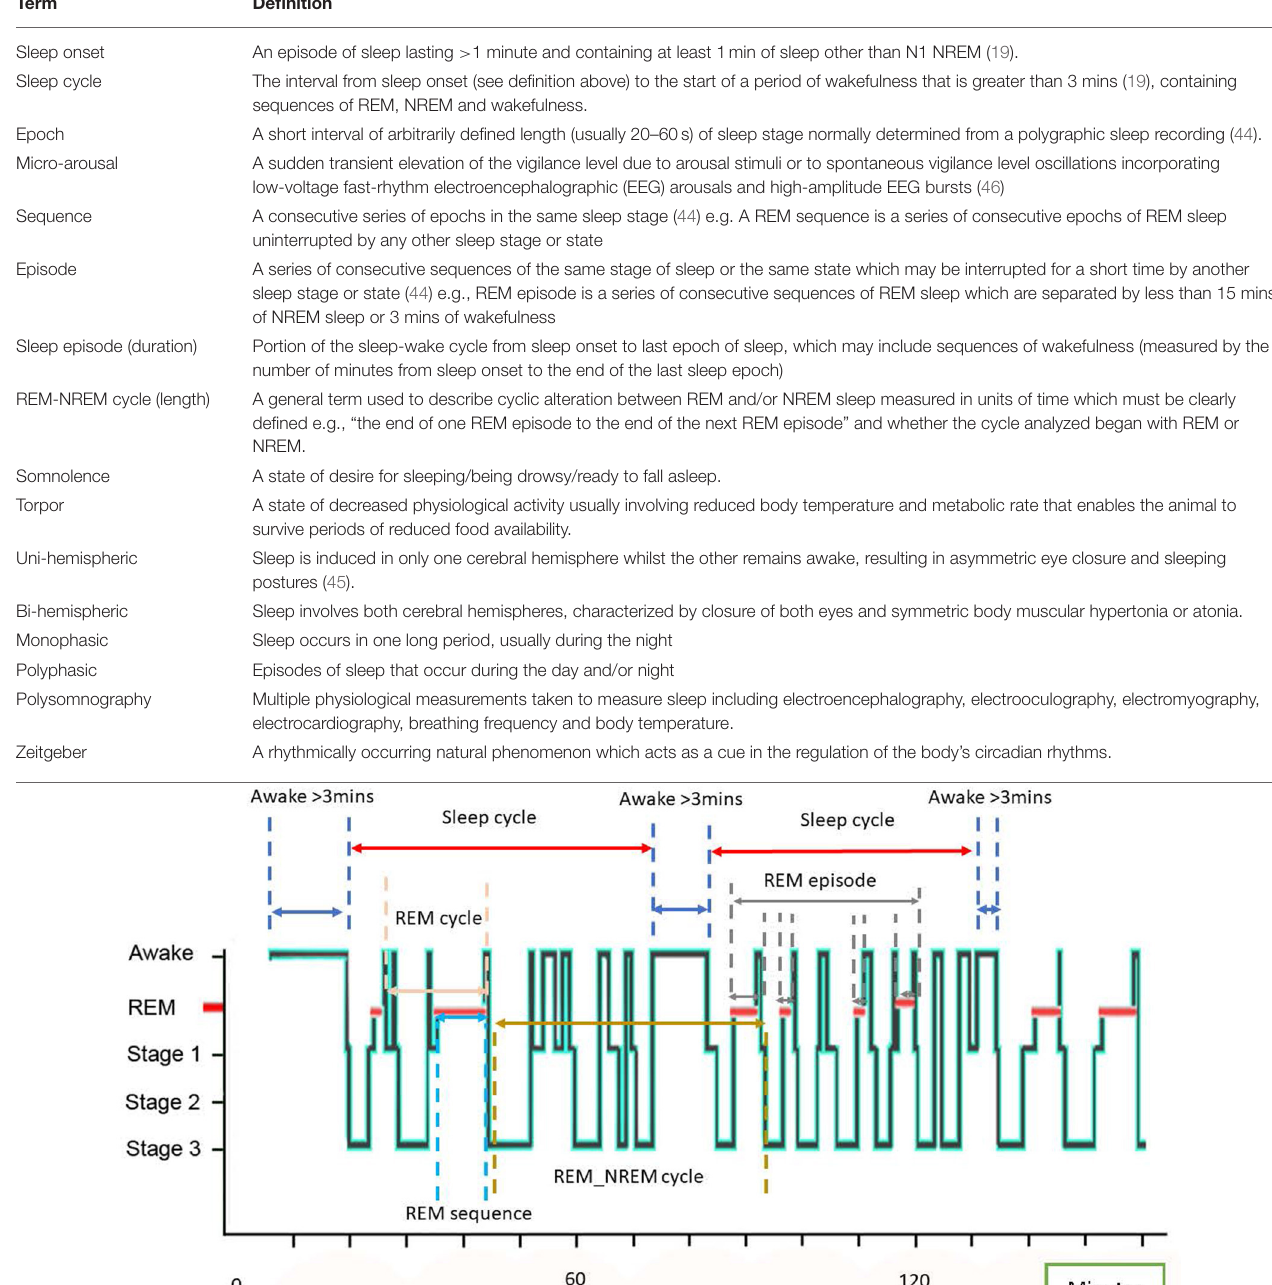
TABLE 2 | A glossary of terms and standard definitions of sleep states (19, 44, 45) with visualization of specific terms using an example equine hypnogram.